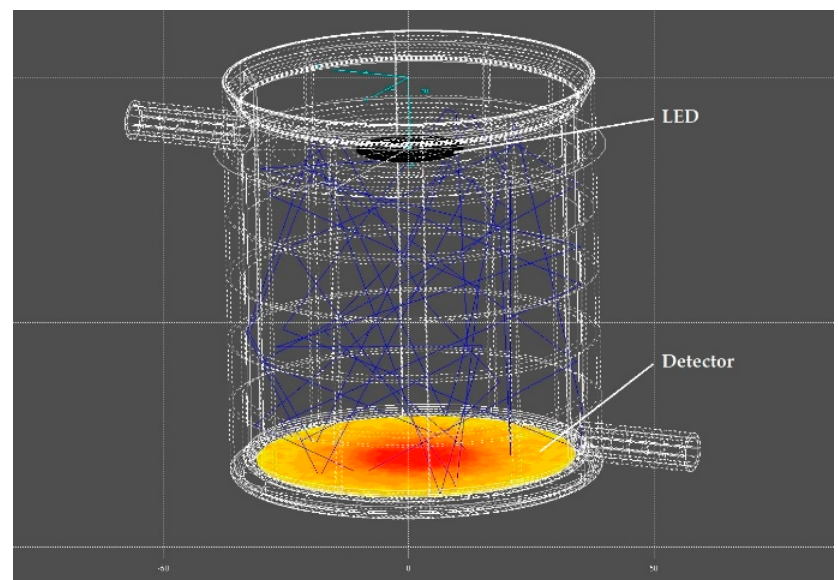
Figure 3. Representation of the raytracing setup with a beam reflected 50 times. The detector visualizes the irradiance in false colors.